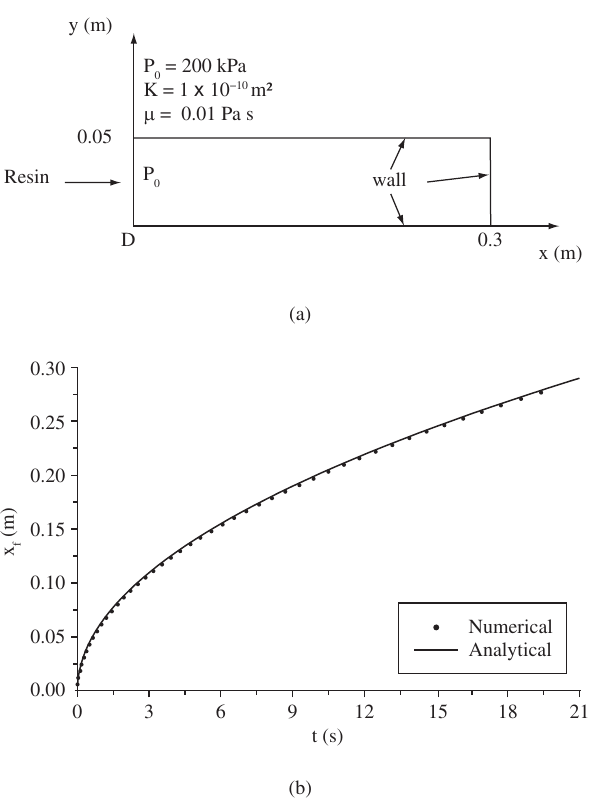
Figure 5. Boundary injection from one side of a rectangular mold: a) Problem sketch, and b) Analytical and numerical solution comparison.